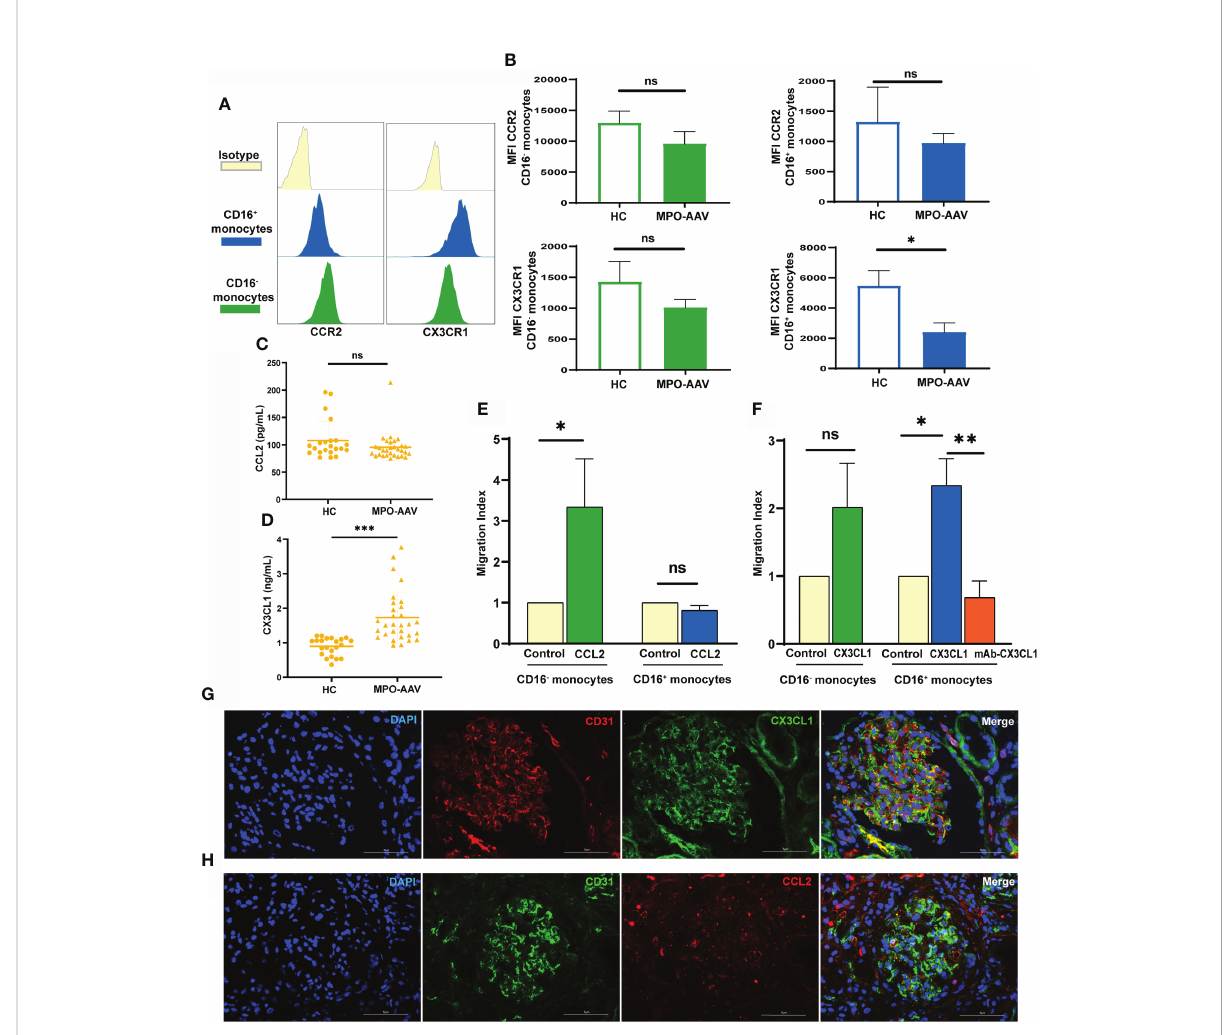
FIGURE 2 Altered CX3CL1-CX3CR1 axis and increased CD16 + monocytes migration in MPO-AAV patients with renal damage. (A, B) Histogram with plot diagrams of fl ow cytometry analysis show the mean fl uorescence intensity (MFI) of CCR2 and CX3CR1 in monocyte subsets from MPO-AAV patients and HC. (C) The concentrations of CCL2 and (D) CX3CL1 were measured in the plasma of MPO-AAV patients with renal damage and HC. (E) In vitro migration assay of isolated monocytes from HC (n=6) with CCL2 and (F) CX3CL1, control wells were used as an indicator of conversion ef fi ciency to calculate migration index. ns, not signi fi cant. * p <0.05; ** p <0.01; *** p < 0.001. (G) Double immuno fl uorescence staining was performed to show glomerular endothelial cells (CD31, red) expressing CX3CL1 (green) and (H) glomerular endothelial cells (CD31, green) expressing CCL2 (red) in MPO-AAV patients. Nuclei were stained with DAPI